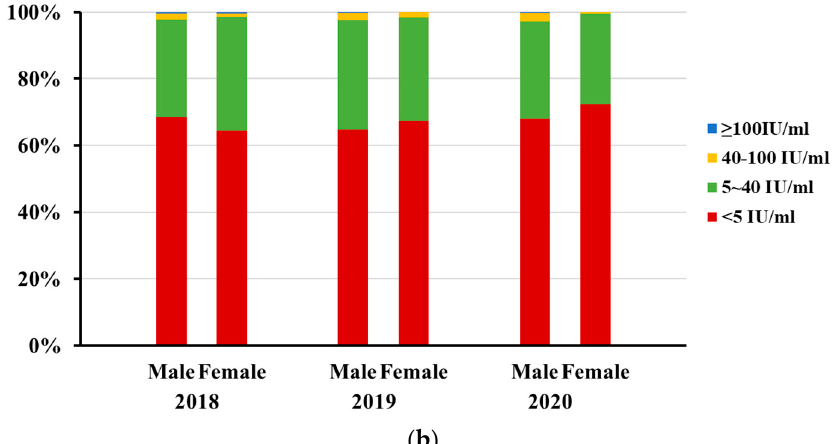
Figure 3. Distribution of serum anti-PT IgG antibody concentrations in adults aged 20~39, Beijing, China, 2018–2020. The numbers of serum specimens with anti-PT IgG antibody concentrations ≥ 100 IU/mL, 40~100 IU/mL, 5~40 IU/mL, and <5 IU/mL in each group were calculated, and the data are shown as percentages. ( a ) Distribution of serum anti-PT IgG antibody concentrations in adults aged 20~29 y and 30~39 y in each year. A significant difference was found in the non-detectable (<5 IU/mL) rate of anti-PT IgG antibodies between the 20~29 y and 30~39 y age groups in 2018 ( p = 0.025). ( b ) Distribution of serum anti-PT IgG antibody concentrations in males and females in each year. No statistical differences were observed in non-detectable (<5 IU/mL) rate of anti-PT IgG antibodies between genders in any year.